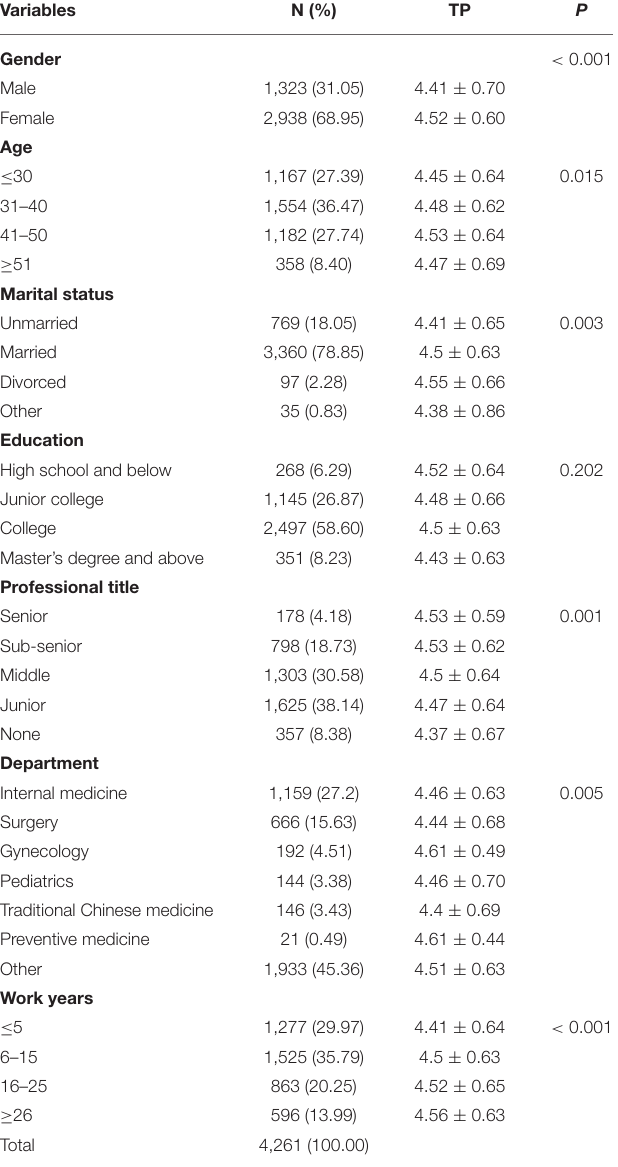
TABLE 2 | Correlations among task performance, work stress, health-related quality of life and presenteeism.